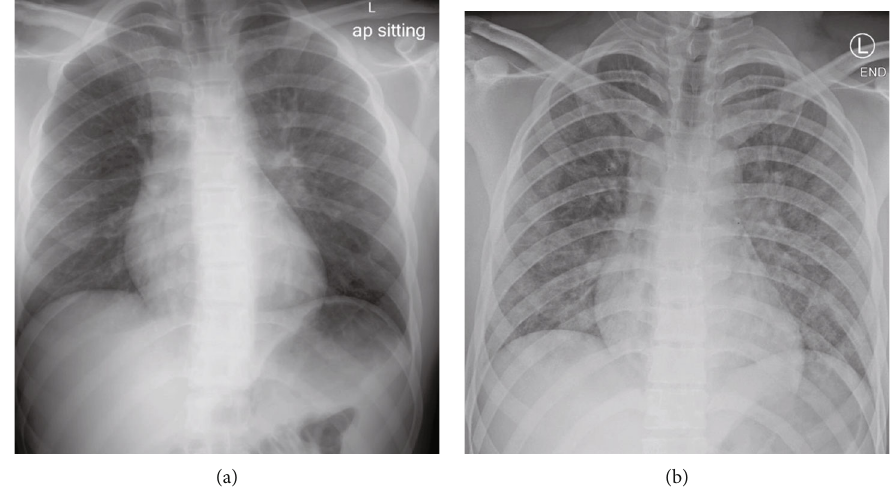
Figure 2: Chest radiographs. (a) Chest radiograph from the morning after right tibia fracture demonstrates mild, di ff use ground-glass opacities. (b) Chest radiograph from the time of rapid response for worsening neurocognitive and respiratory status demonstrates worsening di ff use pulmonary in fi